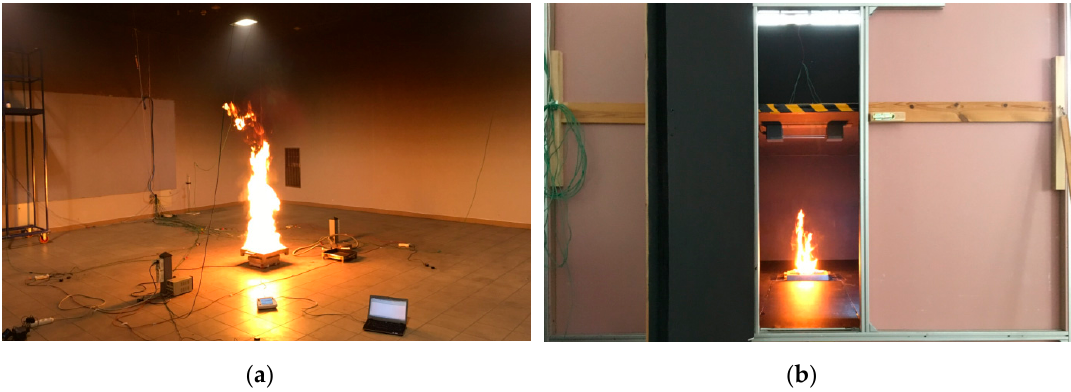
Figure 9. ( a ) Full-scale and ( b ) reduced-scale (1:4) experiments on the free burning of n-heptane.